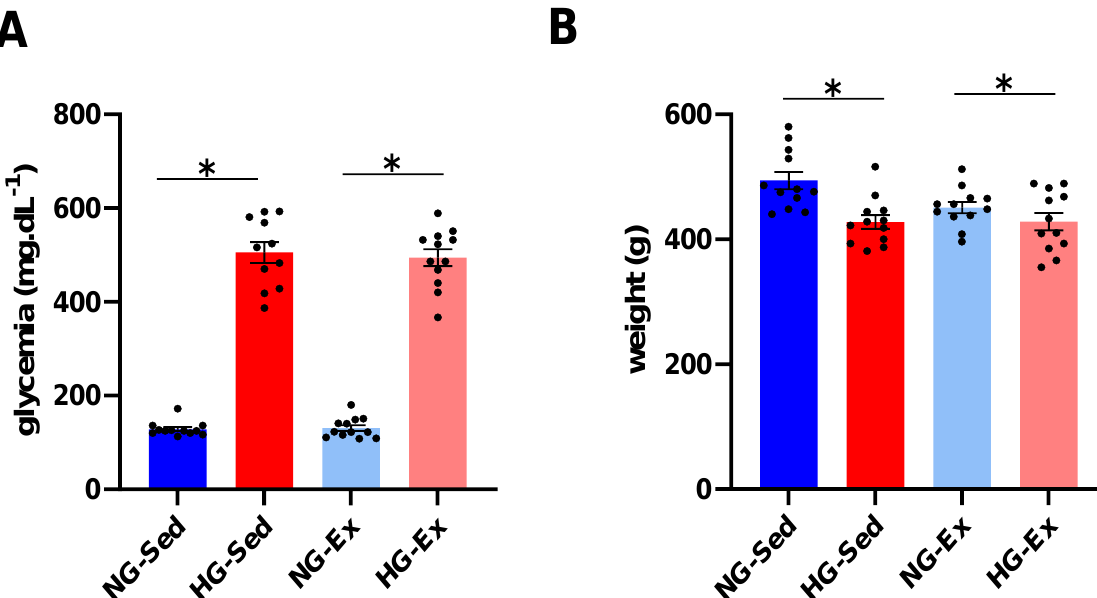
Figure 1. Impact of streptozotocin and exercise training on body weight and glycemia. Impact of hyperglycemia induced by streptozotocin (40 mg · kg − 1 I.P., administered 48 h before ischemia- reperfusion) and exercise training (45 min per day, five times a week for 5 weeks) on ( A ) body weight and ( B ) glycemia of n = 12 rats per group. NG: normoglycemic; Sed: sedentary; HG: hyperglycemic; Ex: exercise training. *: p < 0.05. All values are expressed as the mean ± SEM. Comparison of multiple experimental conditions was performed using analysis of variance (ANOVA) followed by Tukey’s post hoc test.